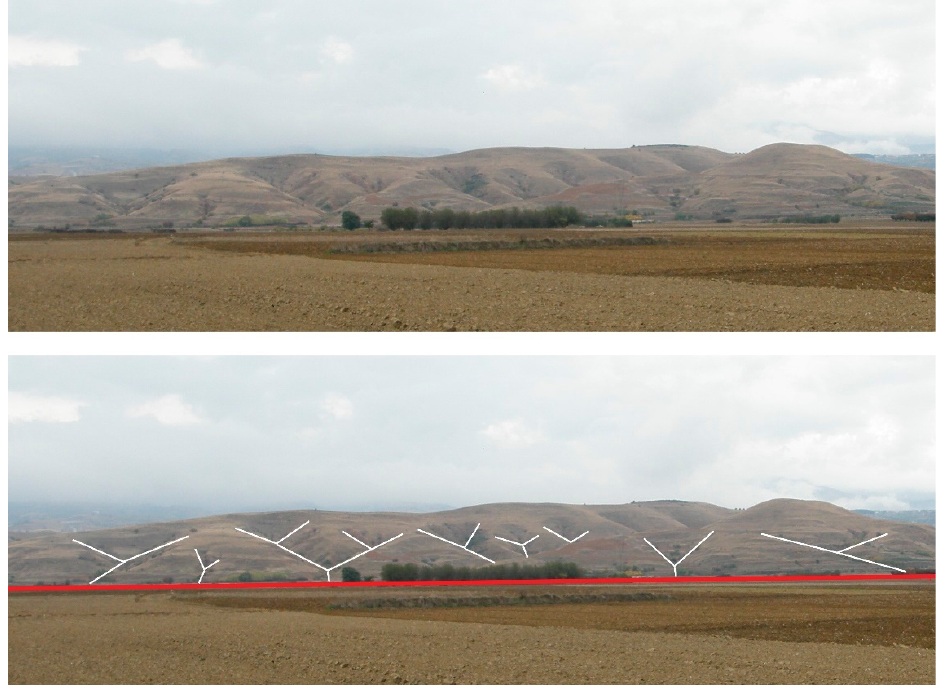
Figure 2. Typical wine-glass valleys, related to the Tholos–Nea Zichni (TNFZ) fault zone, located at the eastern boundary of the Strymon Basin. The red solid line indicates the linear fault trace. White lines show the incised wine-glass valleys indicating footwall uplift. Overall, the fault trace separates uplift from subsidence, controlling the present-day sedimentation processes, and also demonstrating that the fault is active.